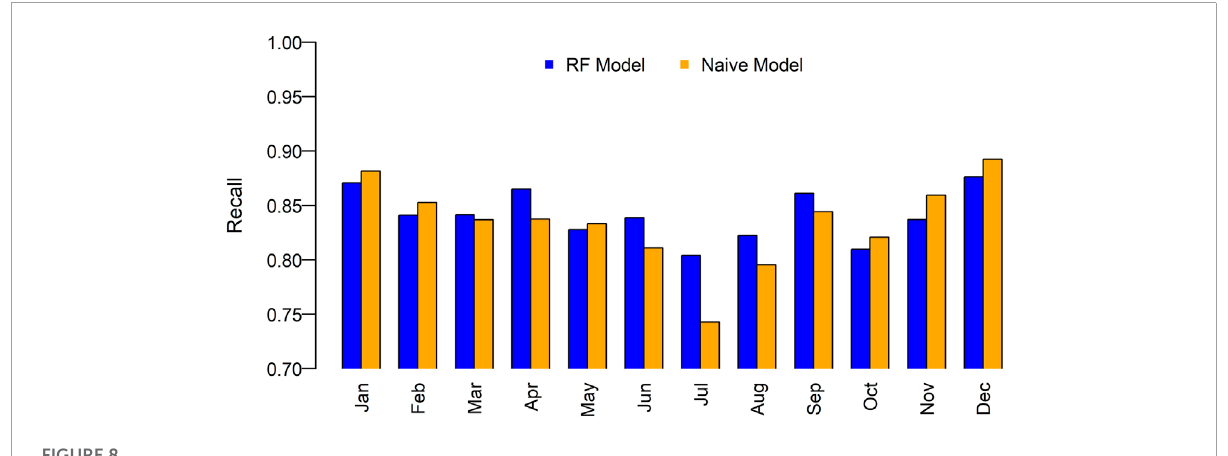
FIGURE 8 Comparison of prediction recall for each month between RF models and naive models.